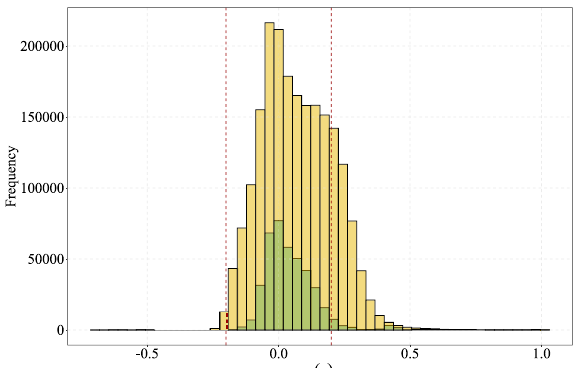
0.2; HMD data in ±